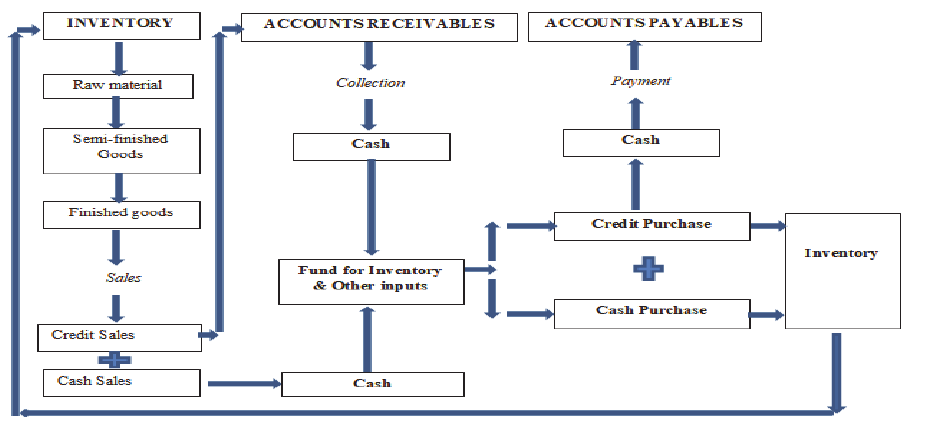
Fig . 1 . Process of Cash Conversion Cycle (CCC)